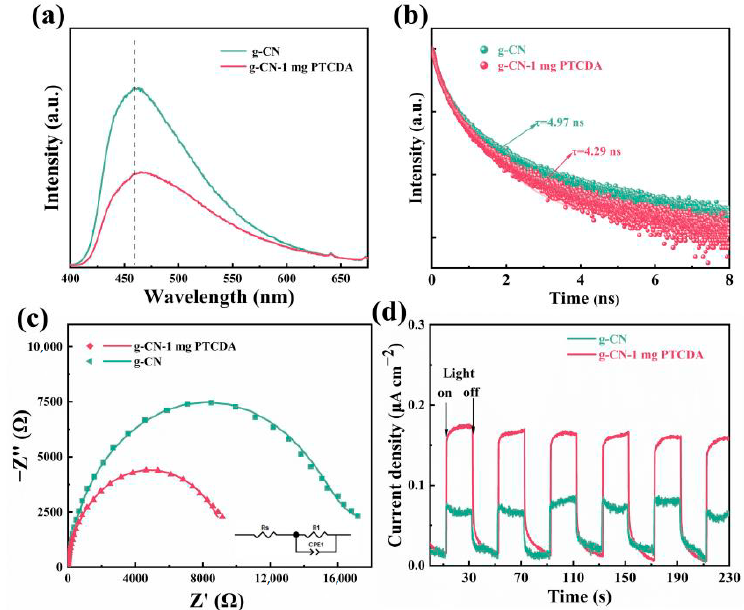
Figure 6. Steady-state PL spectra ( a ), time-resolution PL decay spectroscopy ( b ), Nyquist plots with the inset of the simulated circuit ( c ), photocurrent response ( d ) of the samples of g-CN and g-CN-1 mg PTCDA.